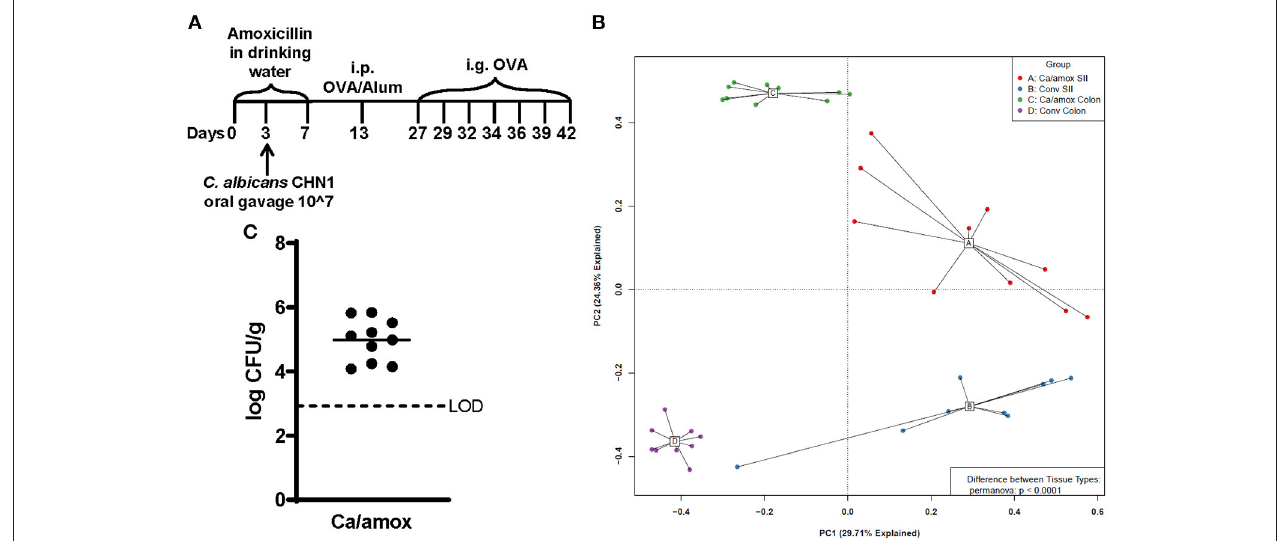
FIGURE 1 | Experimental model and initial composition of microbiome and Candida albicans CHN1 in conventional (Conv) and microbiota disrupted (Ca/amox) Balb/cJ mice. (A) Mice in the Ca/amox group were given amoxicillin in their drinking water for 7 days prior to the initial allergen sensitization. On day 3 of antibiotic administration, C. albicans strain CHN1 was orally given via intragastric gavage (i.g.) at a concentration of 10 7 . On day 13, Conv and Ca/amox mice were intraperitoneally (i.p.) sensitized with 50 µ g endotoxin free ovalbumin and subsequently challenged via i.g. administration with ovalbumin (OVA) dissolved in sterile saline. Each oral challenge occurred after a 3-4h fast every 2 or 3 days for a total of seven complete challenges. Samples were collected for the groups of mice, untreated (Naive) and treated groups (Conv and Ca/amox) after challenge seven on day 42. The measurements included body temperature (0-2h), serology, gastrointestinal snips for RT-qPCR and (B) microbiome principal component analysis, and (C) CFU of C. albicans from the cecal contents. A single dot represents one mouse; n = 9 to 10 mice. LOD is the limit of detection. Statistical significance was determined using PERMANOVA test. Statistical significance is P < 0.05. Small intestine ileum